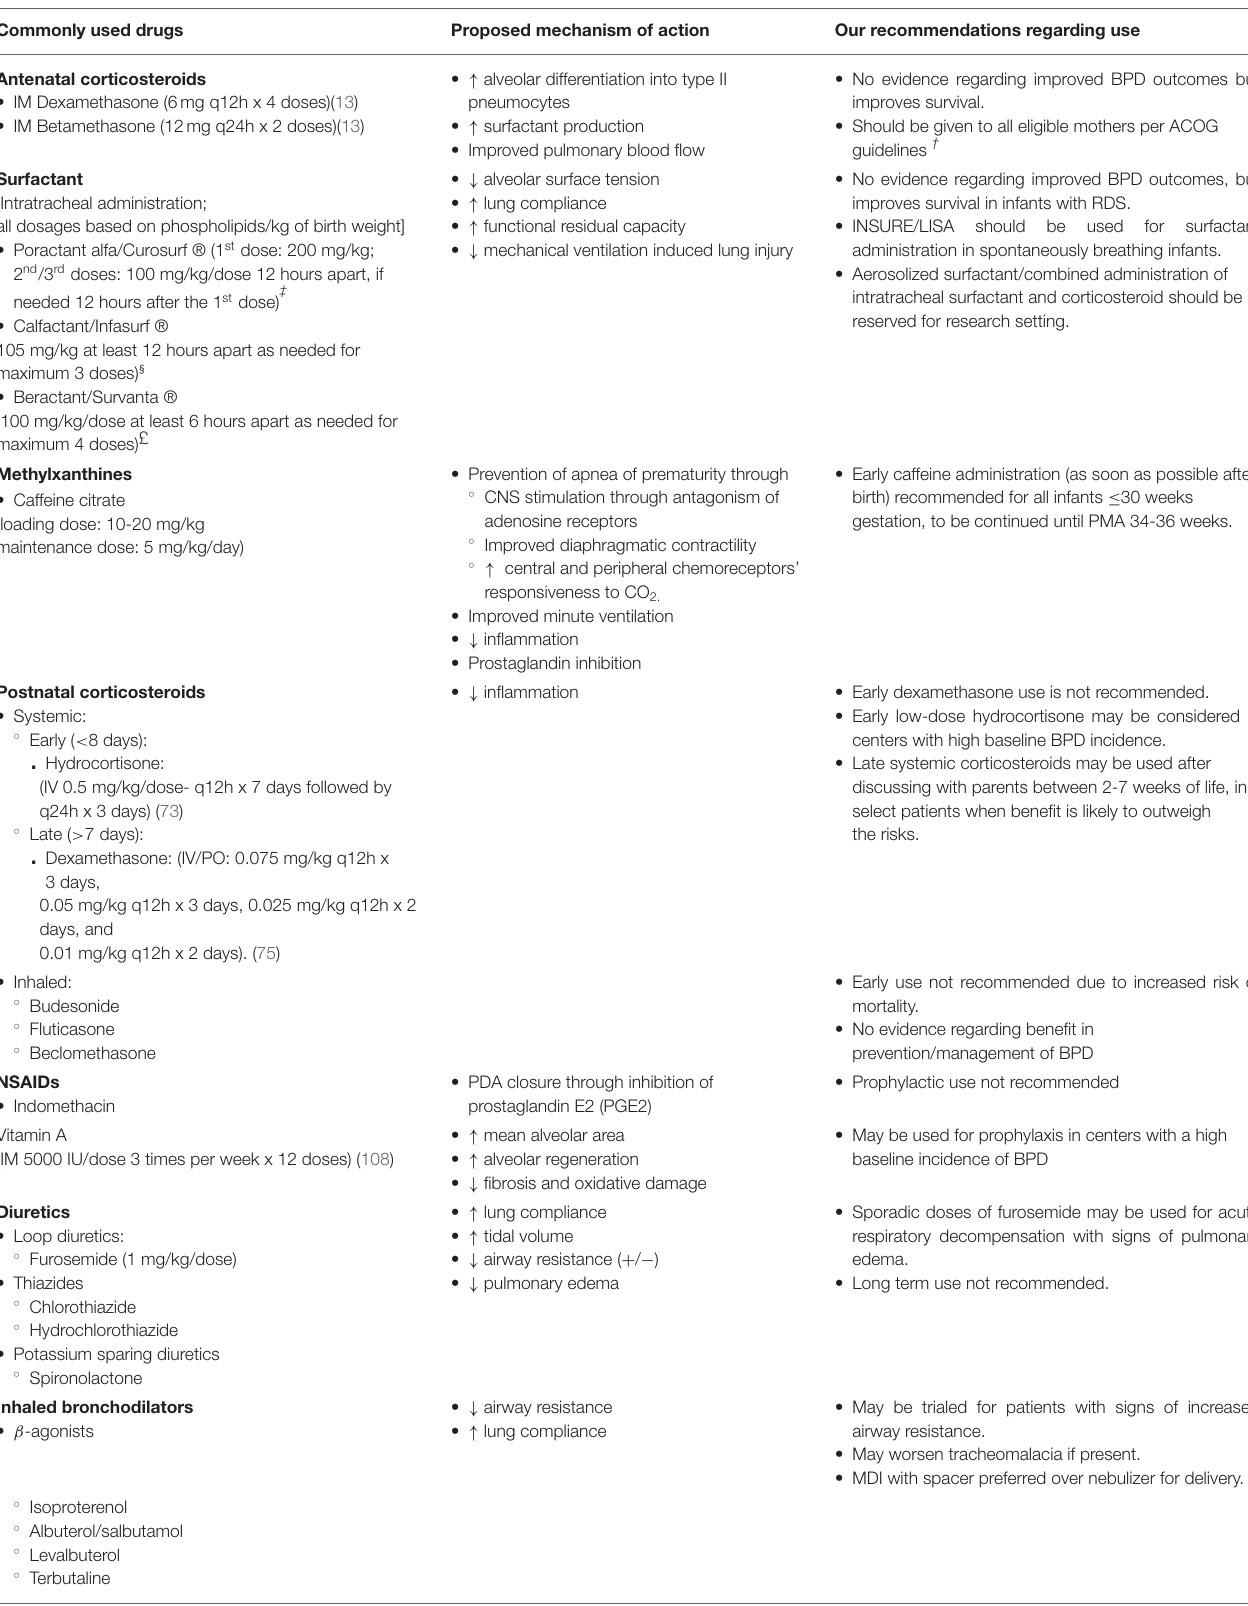
TABLE 1 | Summary of drugs used in infants with BPD. Commonly used